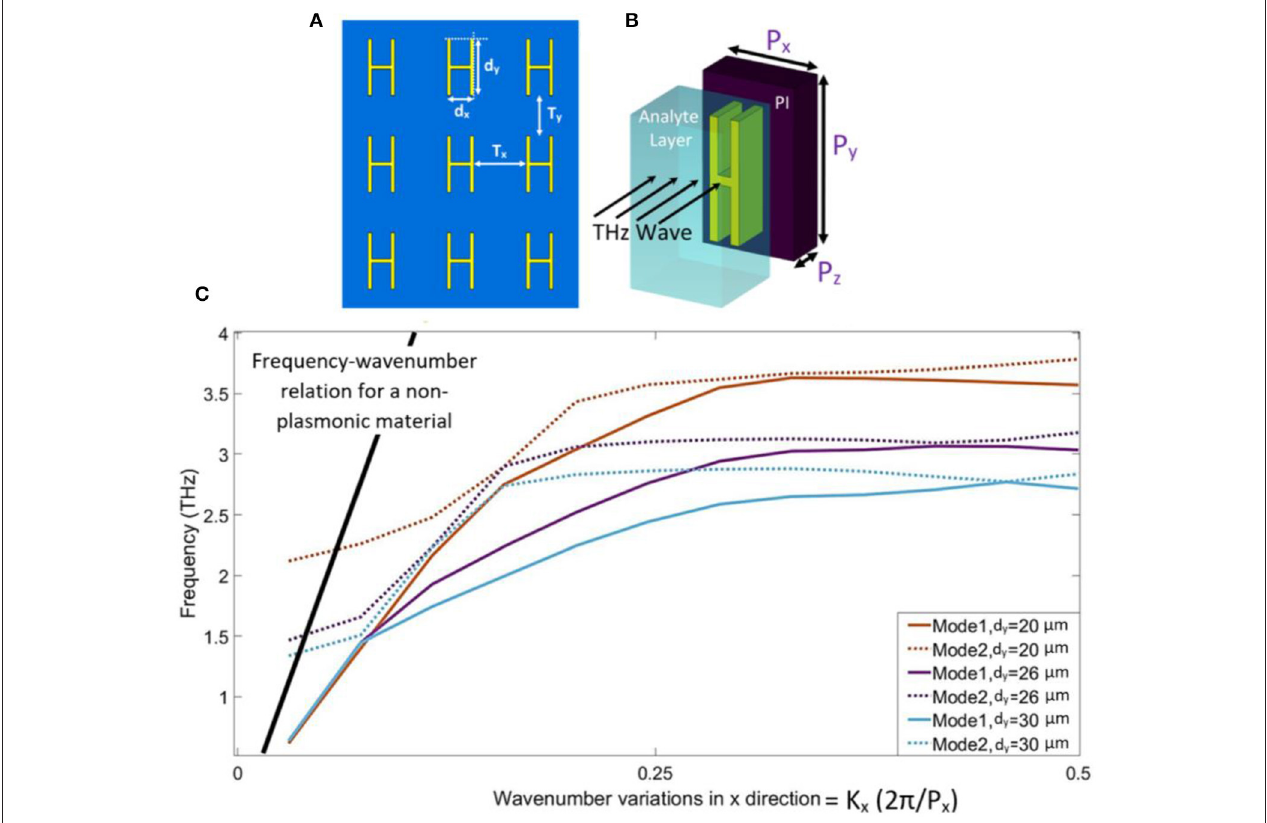
FIGURE 1 | The structure of the proposed THz sensor. A THz wave must be illuminated directly and transmits through the analyte and sensor structure. (A) Structure and the configuration of metal elements in the terahertz metamaterial structure. (B) Unit cell of the metamaterial periodic structure. A layer of polyimide is laid under the metal stripe. (C) Dispersion diagram of the structure. According to the dispersion relation between frequency and wave number, the graph illustrates that the surface plasmon is supported by the structure. There are two main propagation modes in this structure with different plasmon frequencies. The variation in the length of the metal (d y ) can tune the resonance frequency for the desired value. It can be clearly seen that for d y = 20 µ m, the resonance frequency is just above 3.5 THz, for d y = 26 µ m, it is about 3 THz, and when d y = 30 µ m, the resonance frequency is almost 2.2 THz.